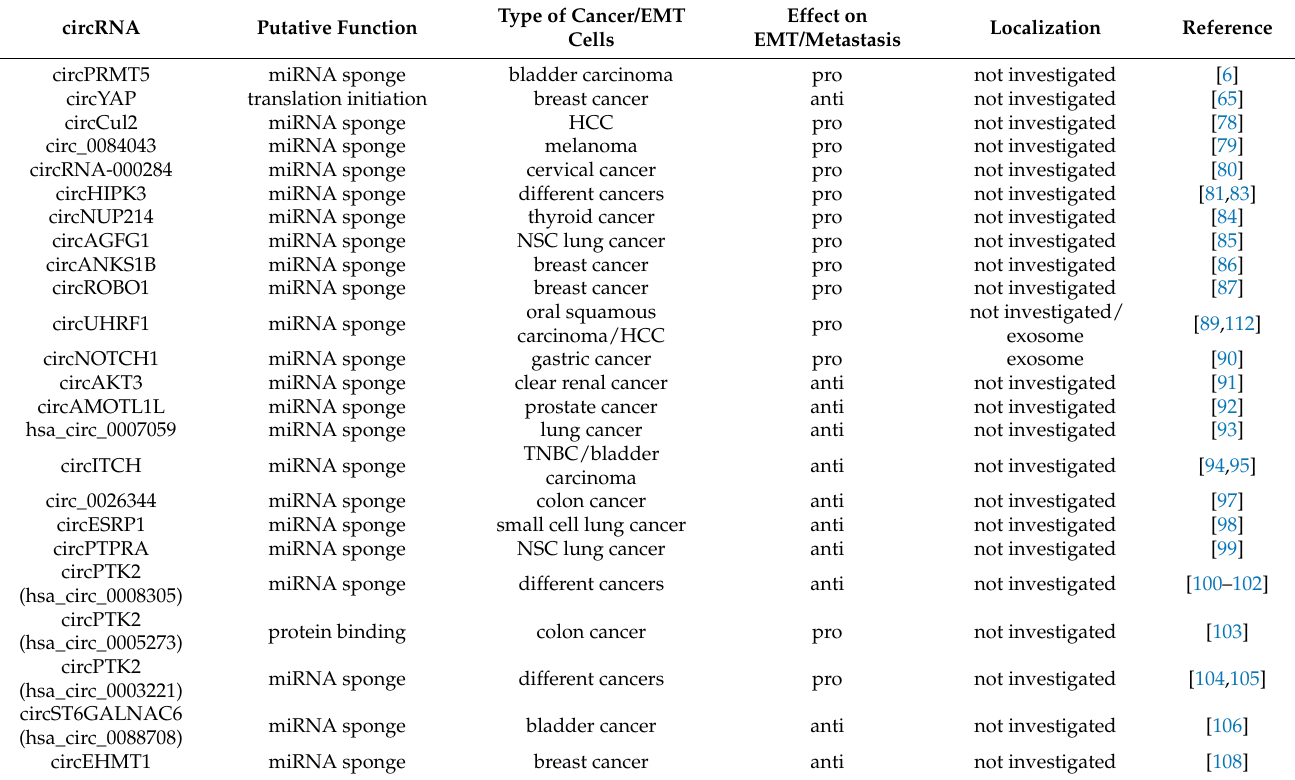
Table 1. CircRNAs with a role in EMT and tumor